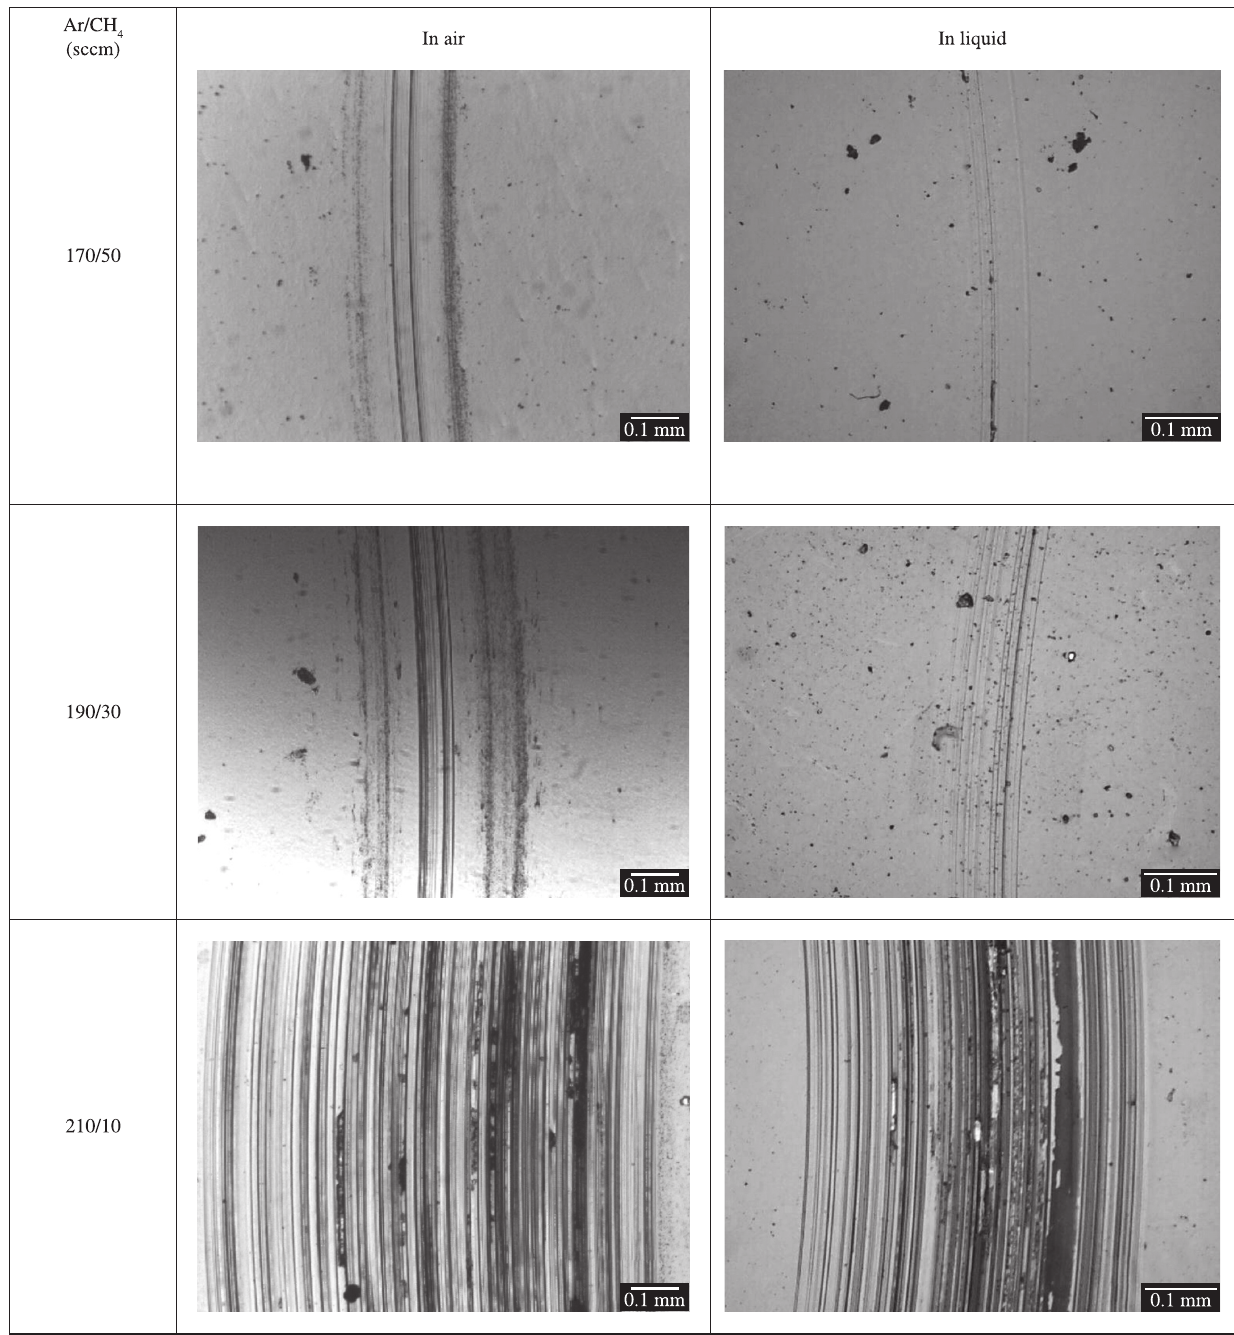
Figure 6. Optical micrographs of tracks formed on the coatings after 50,000 cycles for the tribological tests in air and in liquid (bovine